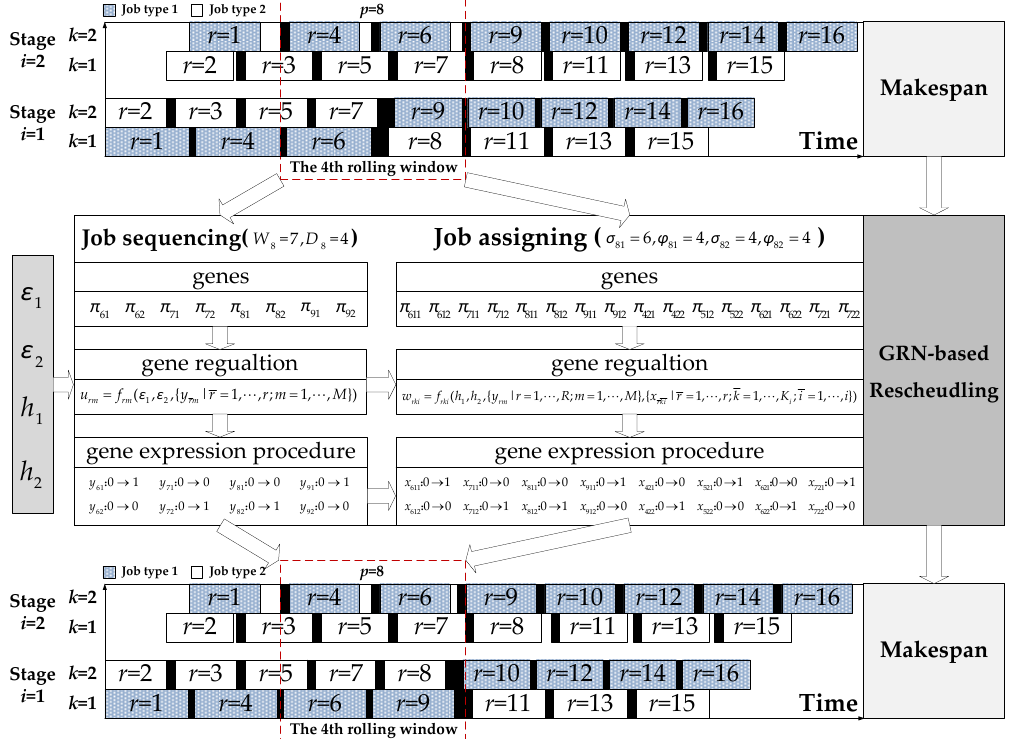
Figure 6. An example of GRN ‐ based rescheduling solution ( M = 2, I = 2, k 1 = 2, k 2 = 2, R = 16, d 1 = 8, d 2 = 8).